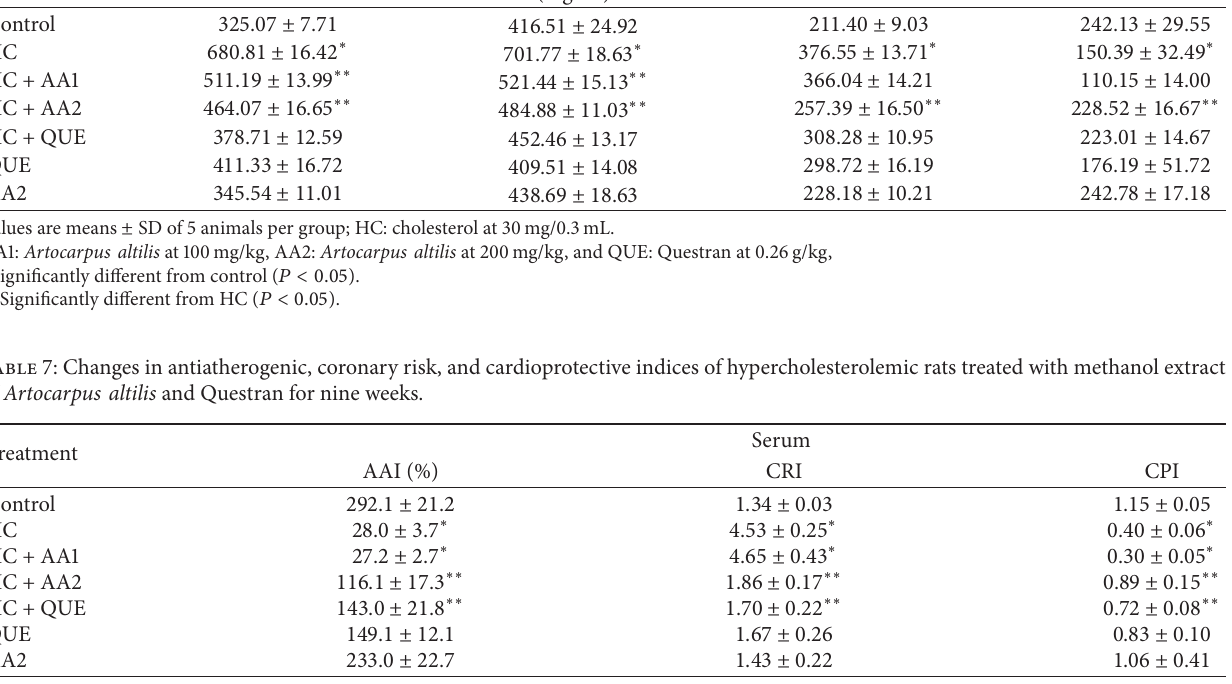
Table 6: Changes in serum lipid profile of hypercholesterolemic rats treated with methanol extract of Artocarpus altilis for nine weeks. Treatment Total chol.